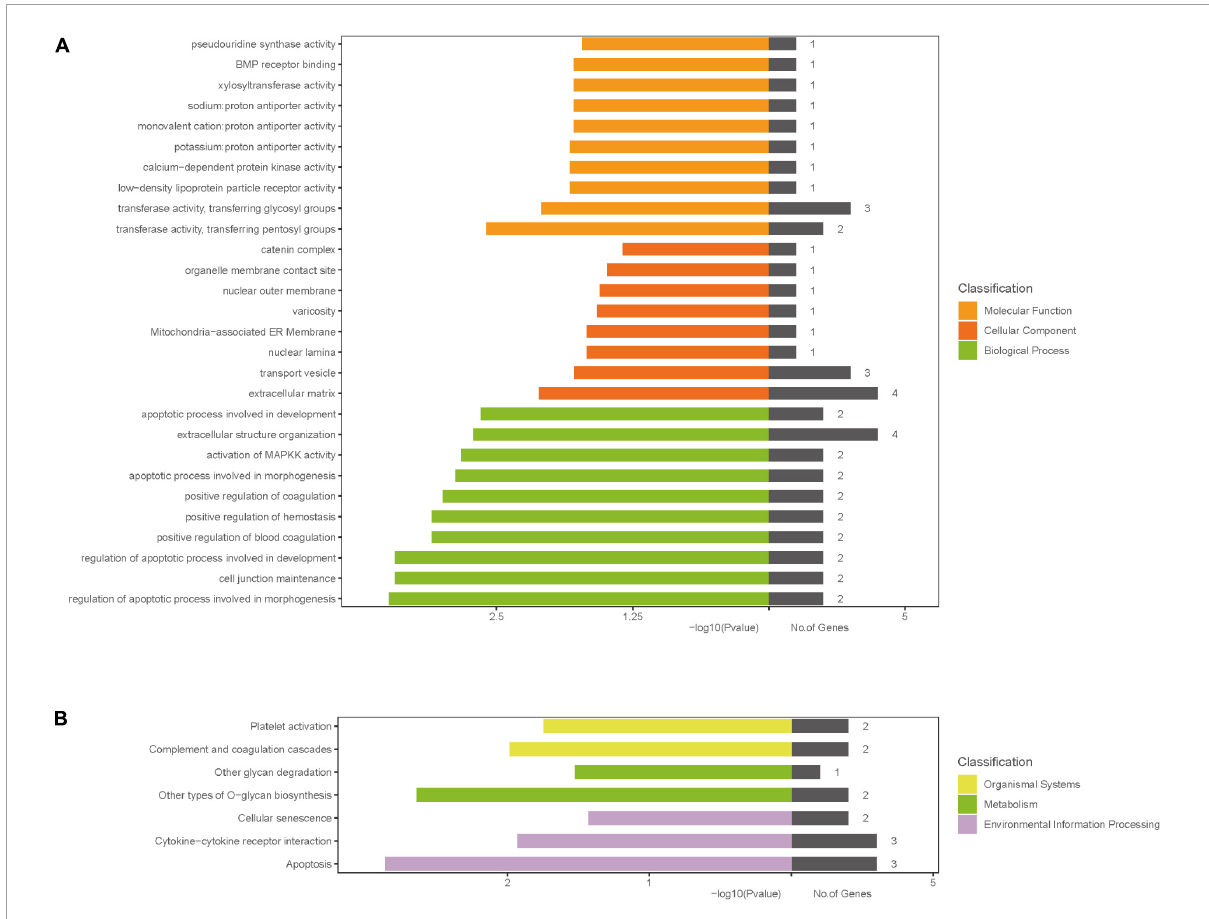
FIGURE3 Gene ontology and KEGG enrichment analysis. (A) GO enrichment result of DEGs; (B) the results of KEGG signaling pathway enrichment analysis; The x -axis label represents P -value and the number of genes and the y -axis label represents GO and KEGG terms, different colors represent different classification. DEGs, differentially expressed genes; GO, gene ontology; KEGG, Kyoto Encyclopedia of Genes and Genomes